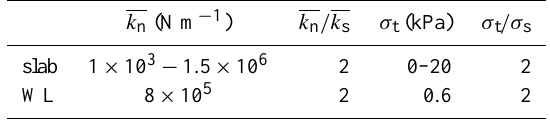
Table 1. Mechanical parameters used in the simulations for the con- tact law. k n : normal contact stiffness; k s : tangential contact stiffness; µ : intergranular friction; e : normal restitution coefficient.